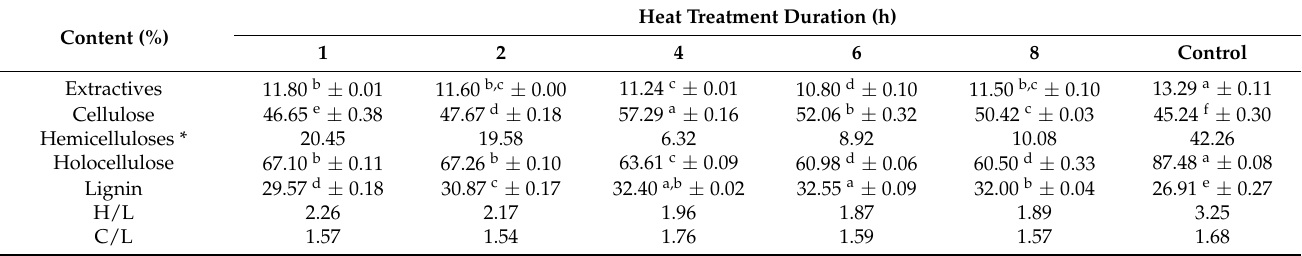
Table 4. Contents of extractives and main components in heat-treated